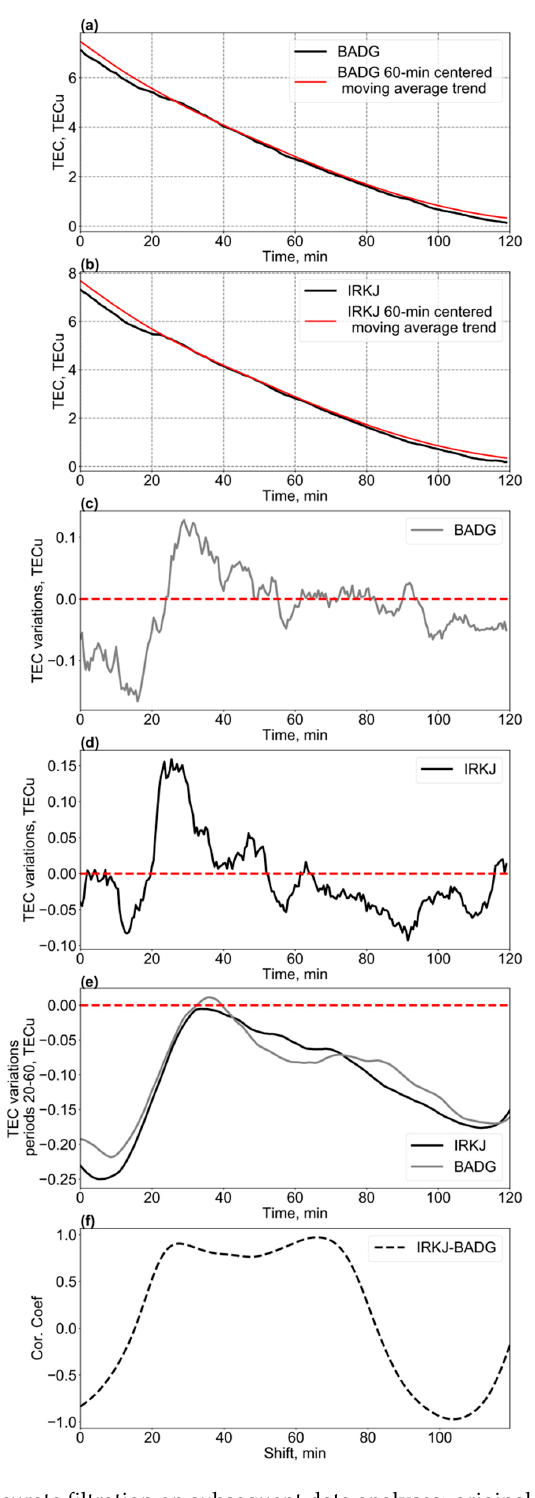
Figure 1. E ff ects of inaccurate filtration on subsequent data analyses: original (black lines) TEC series and 60-min CMA TEC trend (red lines) for IRKJ ( a ) and BADG ( b ) stations; 60-min-CMA-detrended TEC series for IRKJ ( c ) and BADG ( d ); 20–60 min TEC variations ( e ) for IRKJ (black line) and BADG (gray line); Cross-correlation functions ( f ) between TEC variation series for IRKJ and BADG. All original TEC series are from G06 satellite signal. Red dashed lines on panel (c–e) show the zero-level.